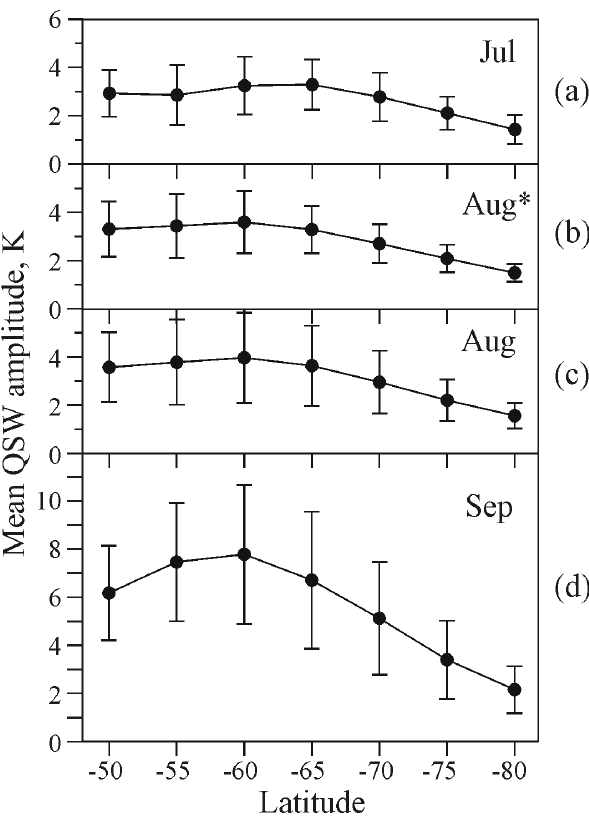
Fig. 5. Meridional structure of the QSW amplitude in the strato- spheric temperature at 100hPa averaged over 1979–2005, for (a) July, (b) August with exception of anomalous 1988 and 2002, (c) August for total data and (d) September.